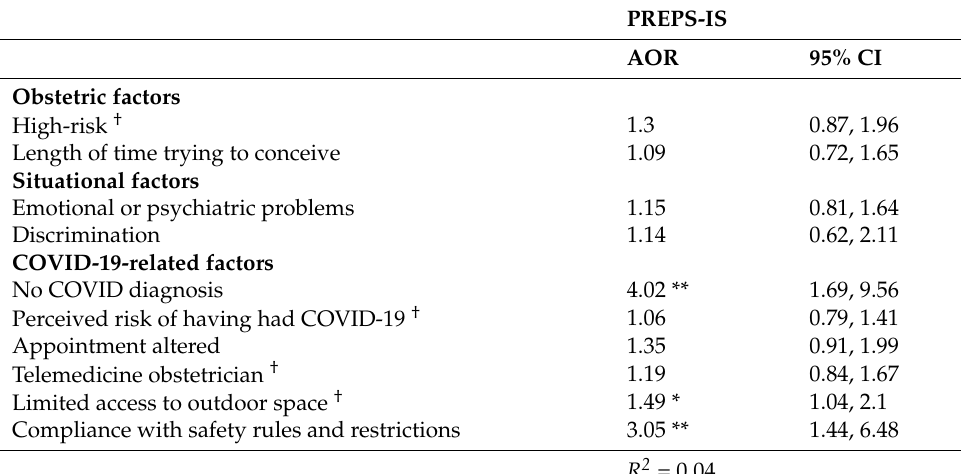
Table 3. Binary multivariate logistic regression predicting high levels of Infection Stress—PREPS-IS ( N =